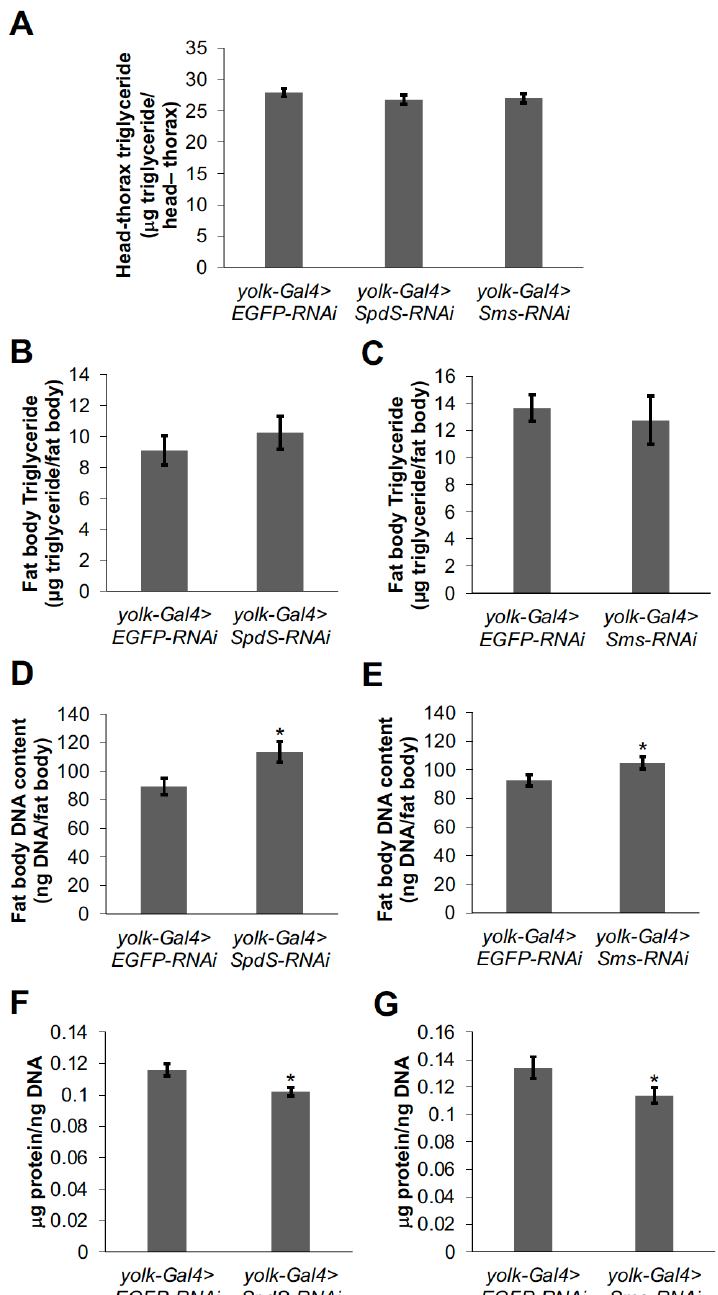
Figure 4. Decreasing either SpdS or Sms in the fat body increases the number but decreases the size of fat body cells. ( A ) Total triglyceride was measured in samples of combined heads and thoraxes dissected from one-week-old female yolk-Gal4>SpdS-RNAi and yolk-Gal4>Sms-RNAi flies and yolk-Gal4>EGFP-RNAi controls ( n = 24–48). A one-way ANOVA was used to compare head–thorax triglycerides in yolk-Gal4>SpdS-RNAi and yolk-Gal4>Sms-RNAi flies, and yolk-Gal4>EGFP-RNAi controls. ( B , C ) Total triglyceride, ( D , E ) total DNA, and ( F , G ) total protein contents were measured in fat bodies dissected from one-week-old female yolk-Gal4>SpdS-RNAi flies and yolk-Gal4>EGFP-RNAi controls ( n = 21–26) and fat bodies dissected from one-week-old female yolk-Gal4>Sms-RNAi flies and yolk-Gal4>EGFP-RNAi controls ( n = 54–55). Protein measurements were normalized by dividing by total DNA content to determine the size of each fat body cell. Bars represent means ± S.E. * p < 0.05 using Student’s t -test comparing yolk-Gal4>SpdS-RNAi or yolk-Gal4>Sms-RNAi flies to the appropriate yolk-Gal4>EGFP-RNAi controls.